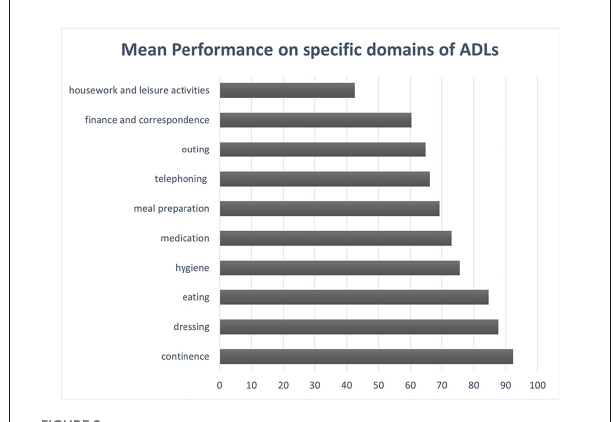
FIGURE2 Mean level of performance on specific domains of ADLs in FTD patients, based on reports provided by knowledgeable informants. ADLs, activities of daily